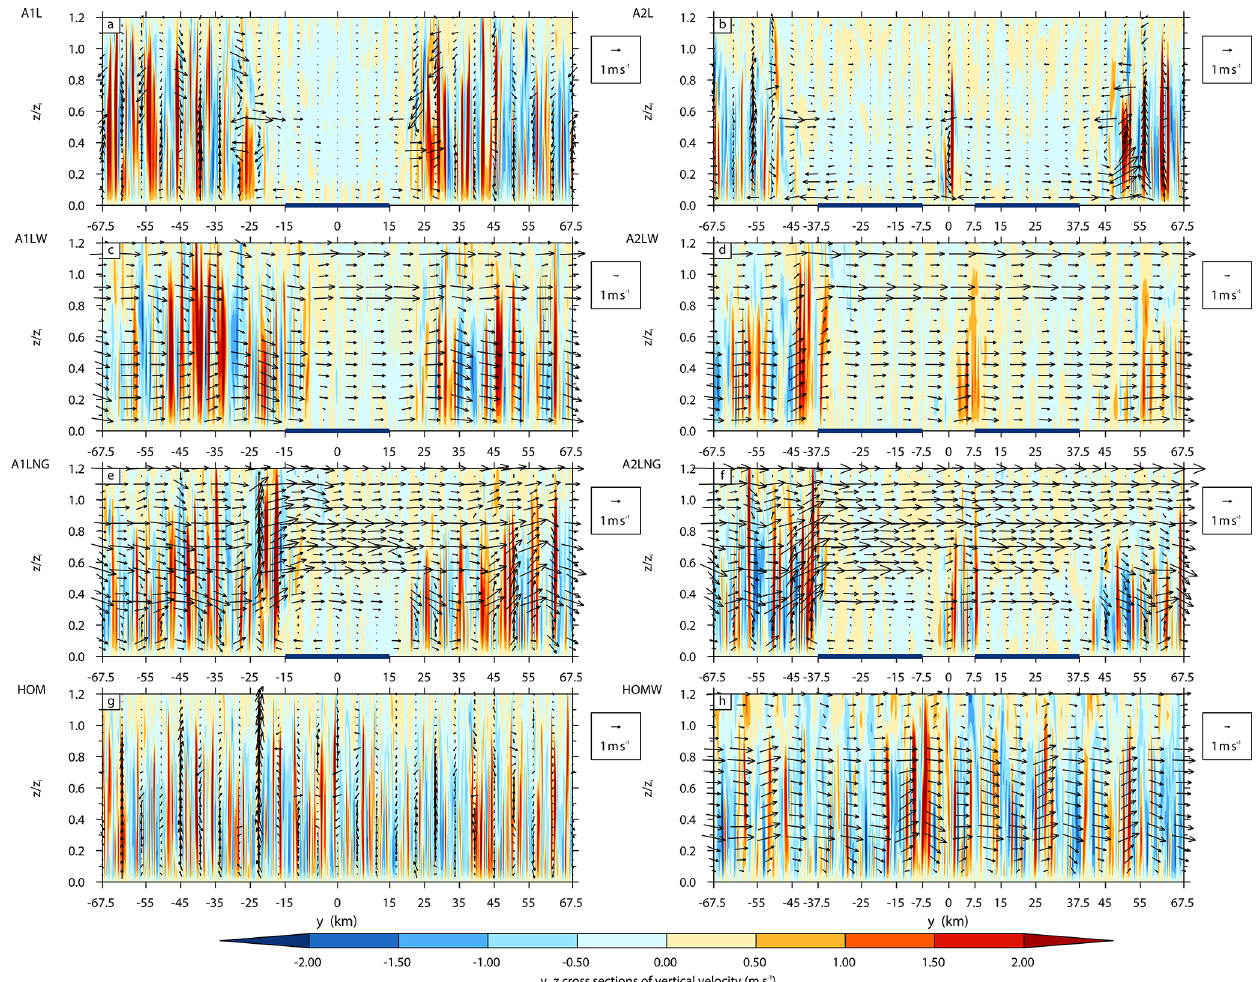
Figure 8. Instantaneous y – z cross sections of the vertical velocity (ms − 1 ) and wind vectors above the heterogeneous surfaces for runs without (a, b) and with (c, d) background wind, with the geostrophic wind removed (e, f) , and the results over homogeneous surfaces for runs with (h) and without (g) background wind. The blue lines represent the lake